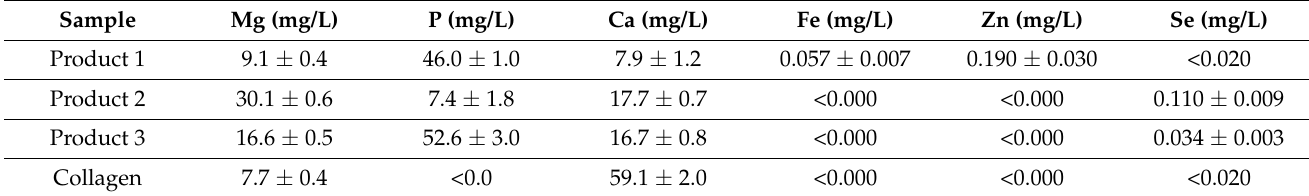
Table 2. Mineral content after simulated gastrointestinal digestion of product 1, product 2, product 3 and collagen.